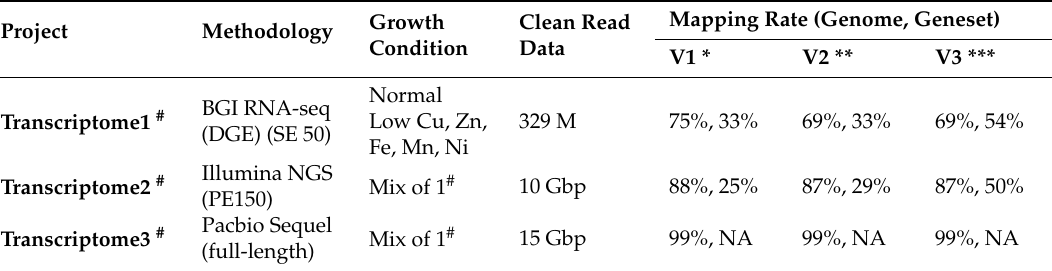
Table 2. RNA-Seq sample information of F. kawagutii